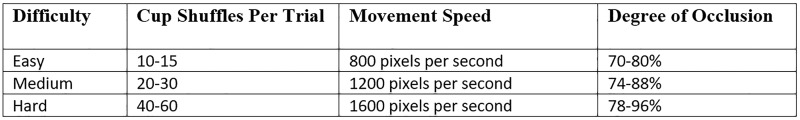
Task difficulty.Shell game difficulty was manipulated by speed of cup movement, the number of shuffles that occurred when two cups were overlapping, and the degree of occlusion when cups were shuffled (for example, a partial to almost full eclipse).